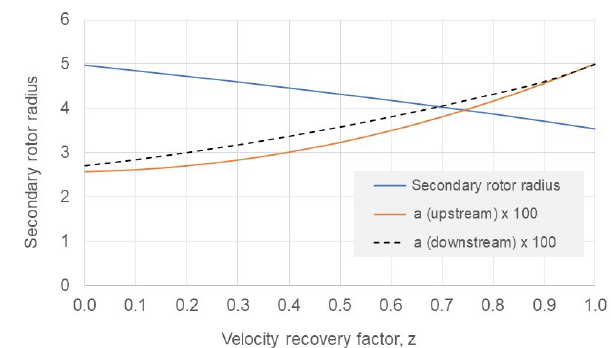
Figure 12. Secondary-rotor radius for no power loss related to ve- locity recovery